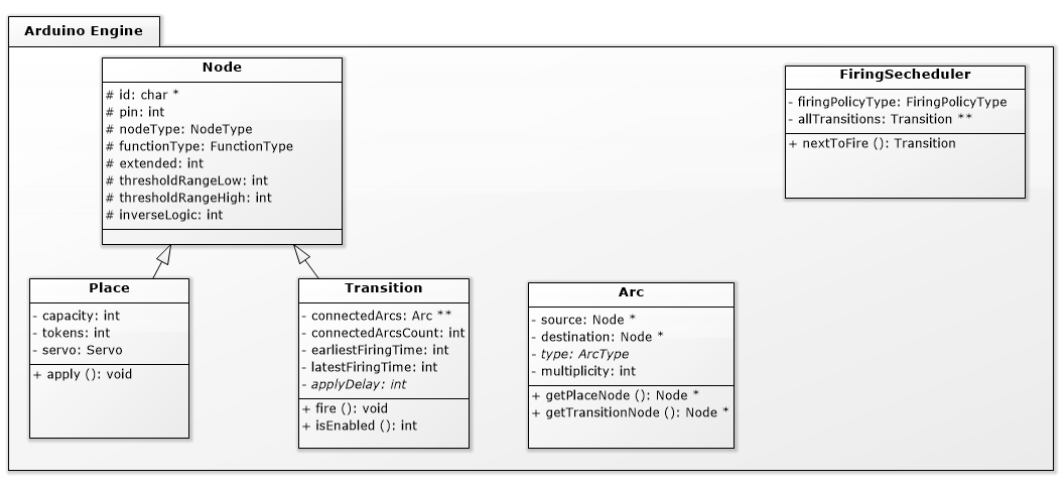
Figure 9. PetriNet engine—class